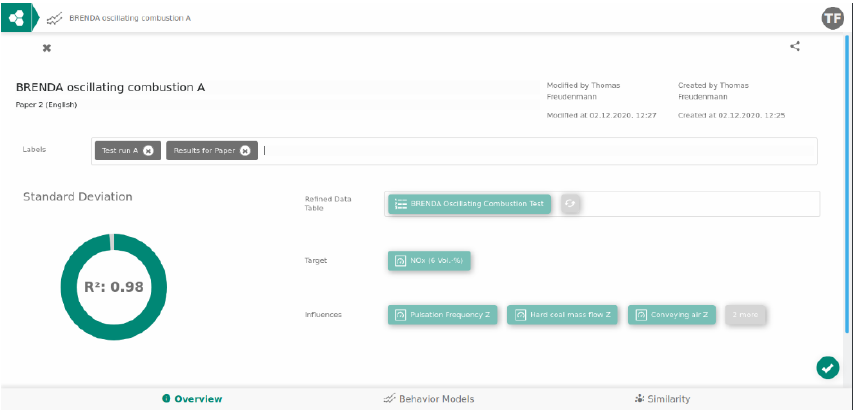
Figure 6. Exemplary overview page of the EDI hive model generator.